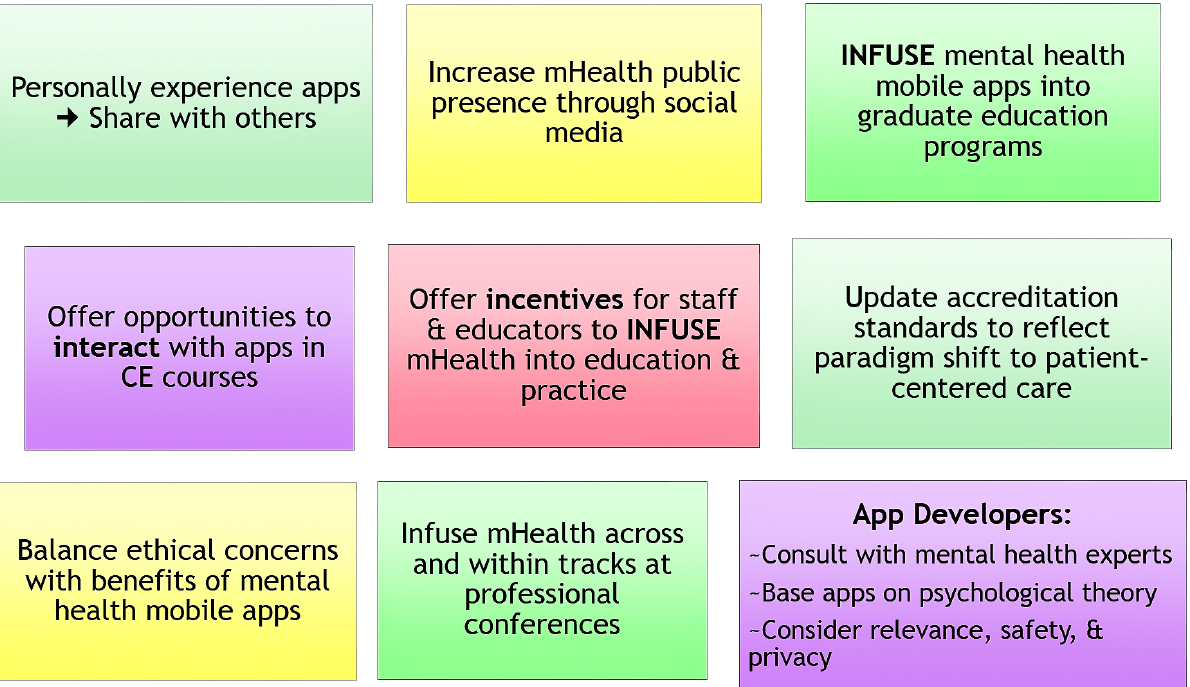
Figure 8. Solutions for impelling diffusion of mental health mobile